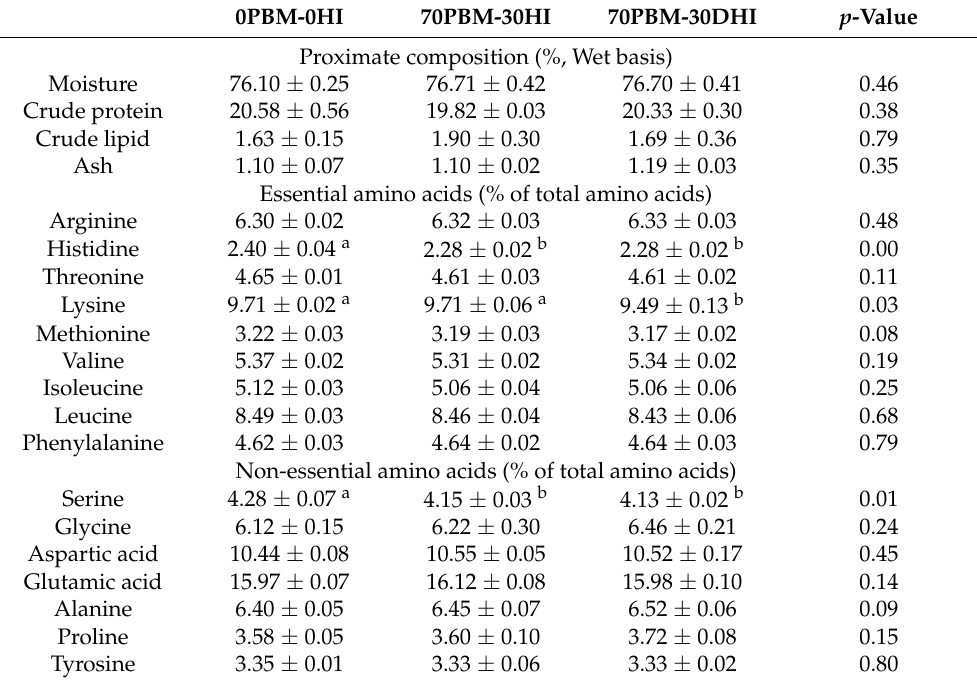
Table 2. The proximate composition and amino acid profiles of skinless whole fillets of barramundi fed with a mixture of poultry by-product meal (PBM), full-fat Hermetia illucens (FHI), and partially defatted Hermetia illucens (DHI) meal for the complete replacement of FM. Values are means of six biological replicates ± the standard error (SE). Means with different superscript letters within the same row indicate significant differences, while means showing no superscript letters indicate no variation among the treatments. Means were compared using a one-way ANOVA with Tukey’s post-hoc multiple comparisons test at p <